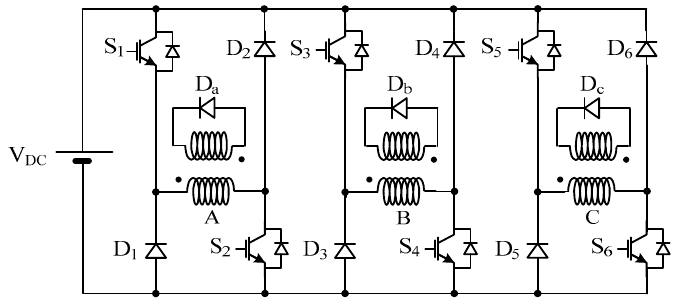
Figure 12. Auxiliary winding topology.